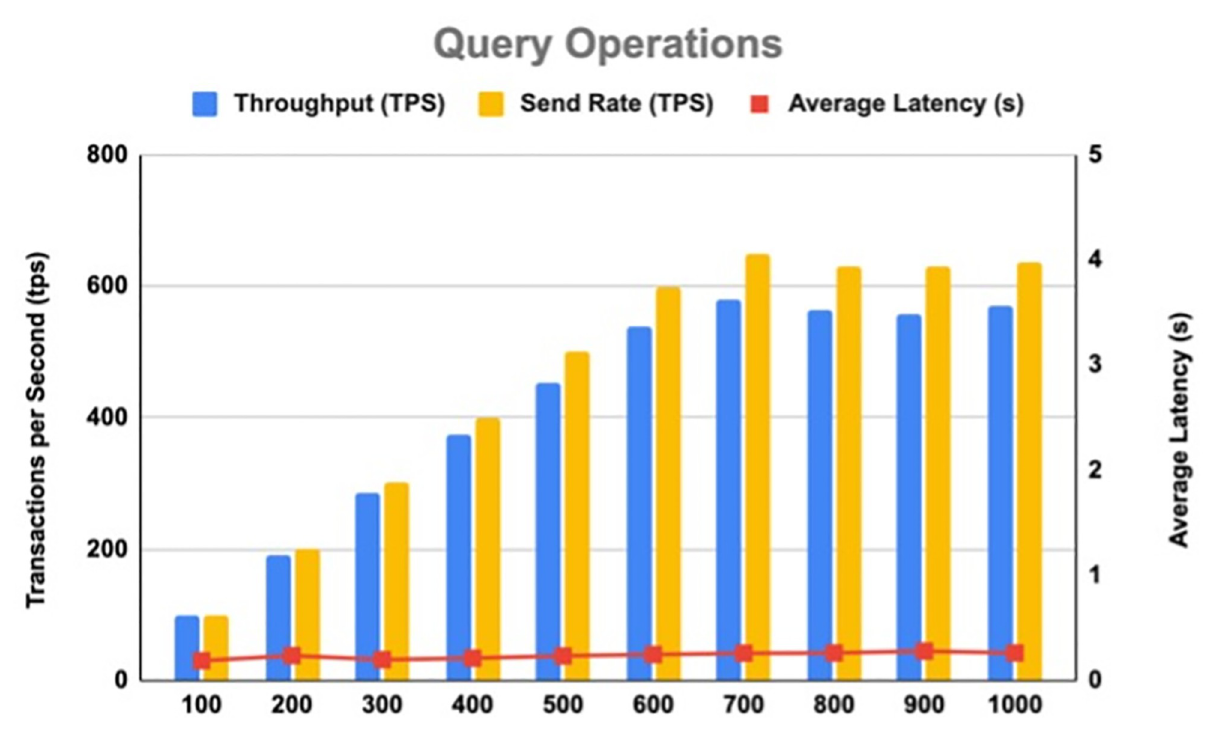
Fig 10. Throughput and latency for query